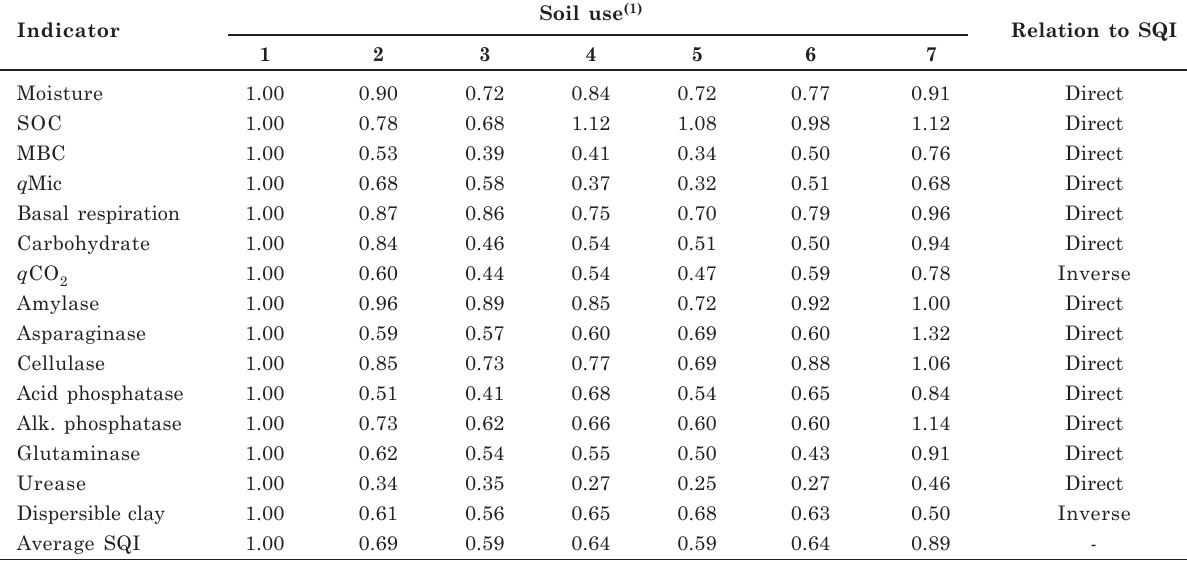
Table 5. Relative values of physical, microbiological and biochemical soil quality indexes (SQI) in soils under different uses (2 to 7), based on the results obtained in the reference site (1), and the average SQI based on 15